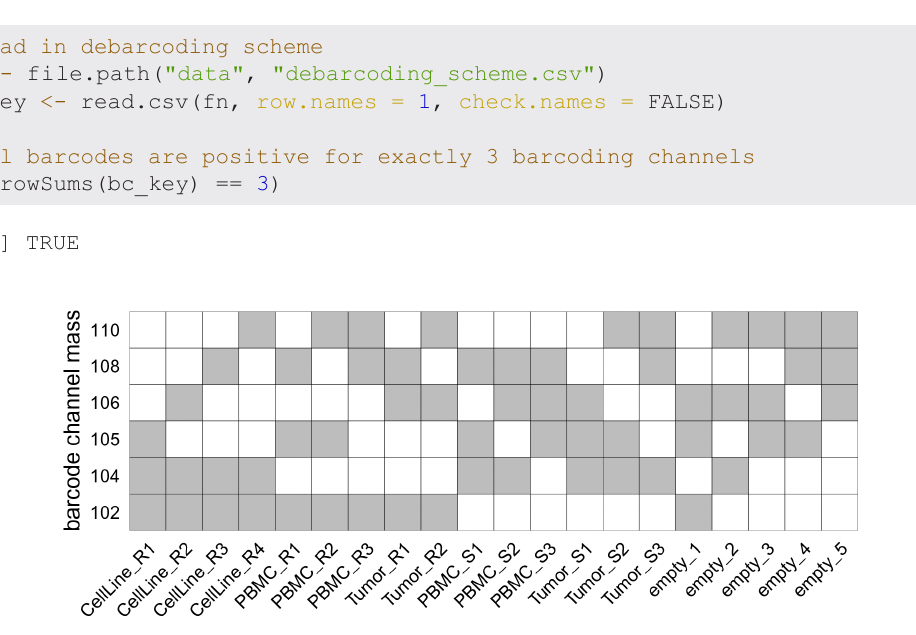
Figure 5. 6-choose-3 palladium isotope debarcoding scheme. Rows correspond to palladium isotopes (barcode channels), columns to barcode identifiers (samples). Each sample is negative (white) or positive (grey) for 3 out of 6 barcode channels, resulting in 20 unique barcode